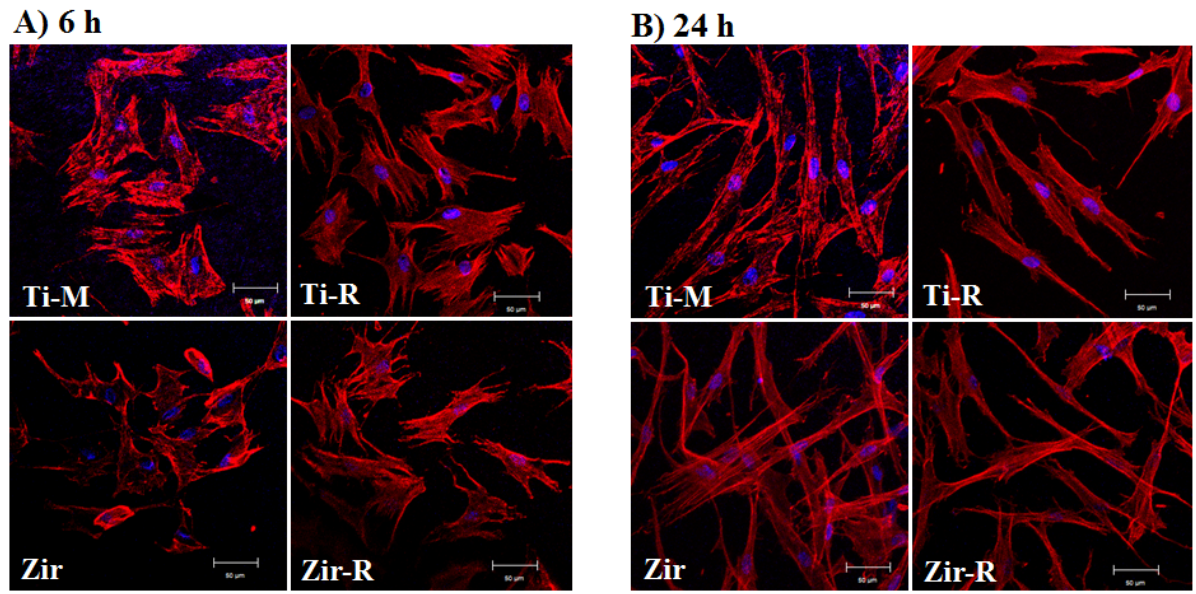
Figure 2. Microscopic observation after human gingival fibroblast (HGF) cells were seeded onto the discs at ( A ) 6 h and ( B ) 24 h. Original magnification is 300× and scale bar = 50 μ m.